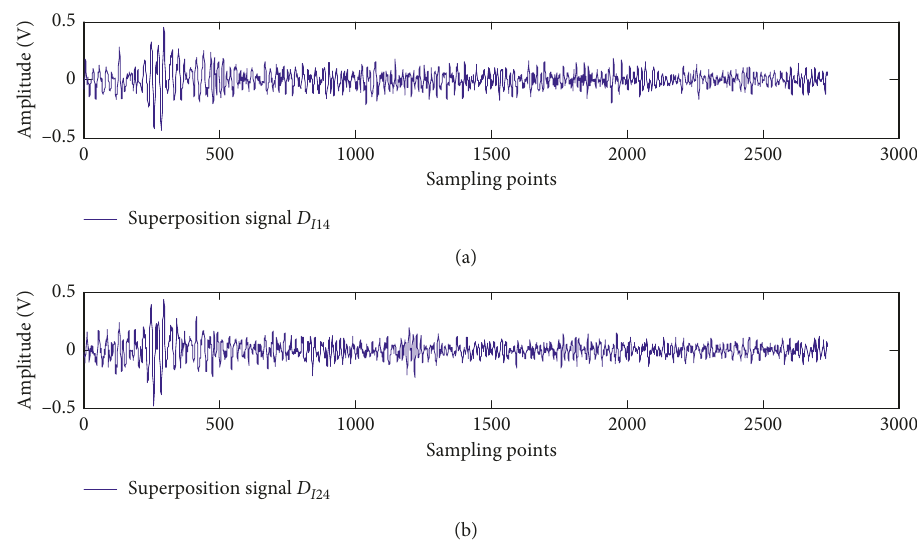
Figure 16: Intercepted sections divided into two groups. (a) The first group includes I I 6 , I 8 , and I 10 .